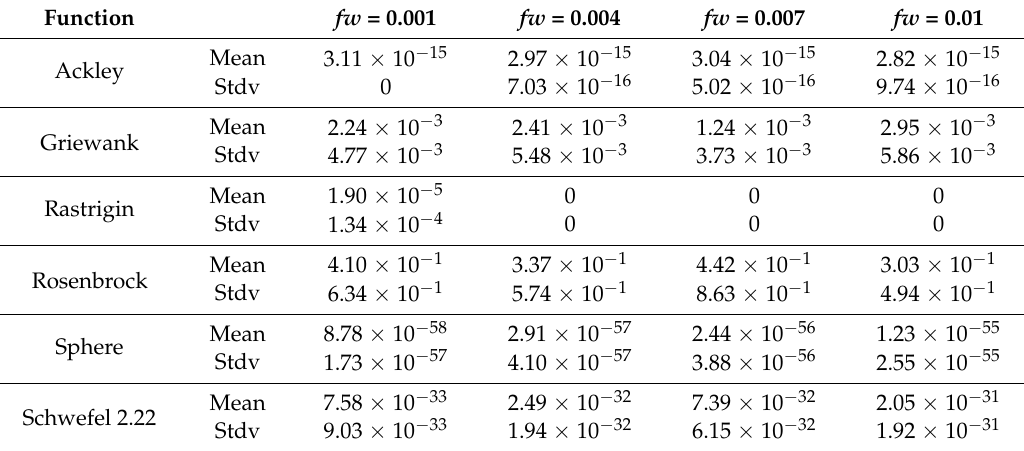
Table 9. The effect of fw on the means and standard